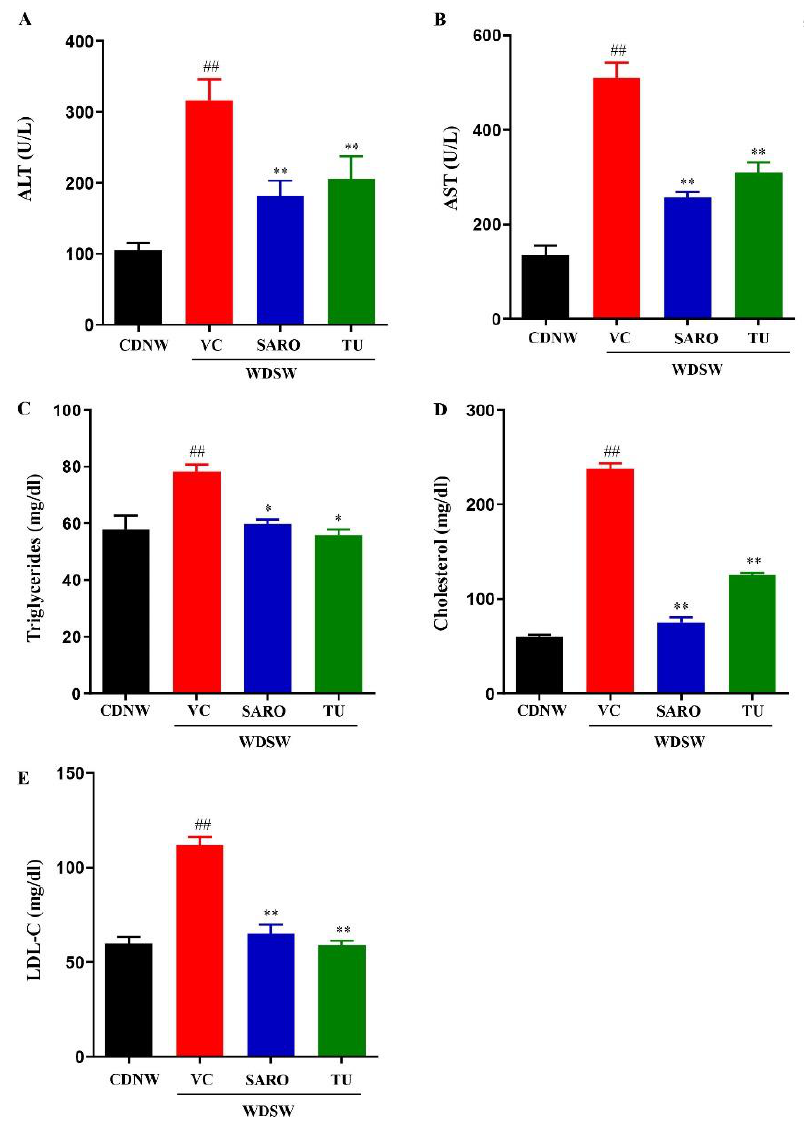
Figure 3. Tecomella undulata ( TU ) treatment reduced liver injury and hyperlipidemia. CDNW or WDSW mice, after 12 weeks, were administered vehicle control (VC), saroglitazar (SARO) or Tecomella undulata (TU) for another 12 weeks. At the end of 24 weeks following dietary intervention and treatment, mice were fasted overnight and blood was collected. ( A ) serum ALT, ( B ) serum ALT, ( C ) serum triglycerides, ( D ) serum cholesterol ( E ) serum LDL-C. Data are expressed as the mean with SEM for 8 – 10 mice per group. ## p < 0.001 compared to CDNW; ** p < 0.001 or * p < 0.05 compared to WDSW, vehicle control. AST, aspartate aminotransferase; ALT, alanine aminotransferase; LDL-C, low-density lipoprotein-cholesterol.